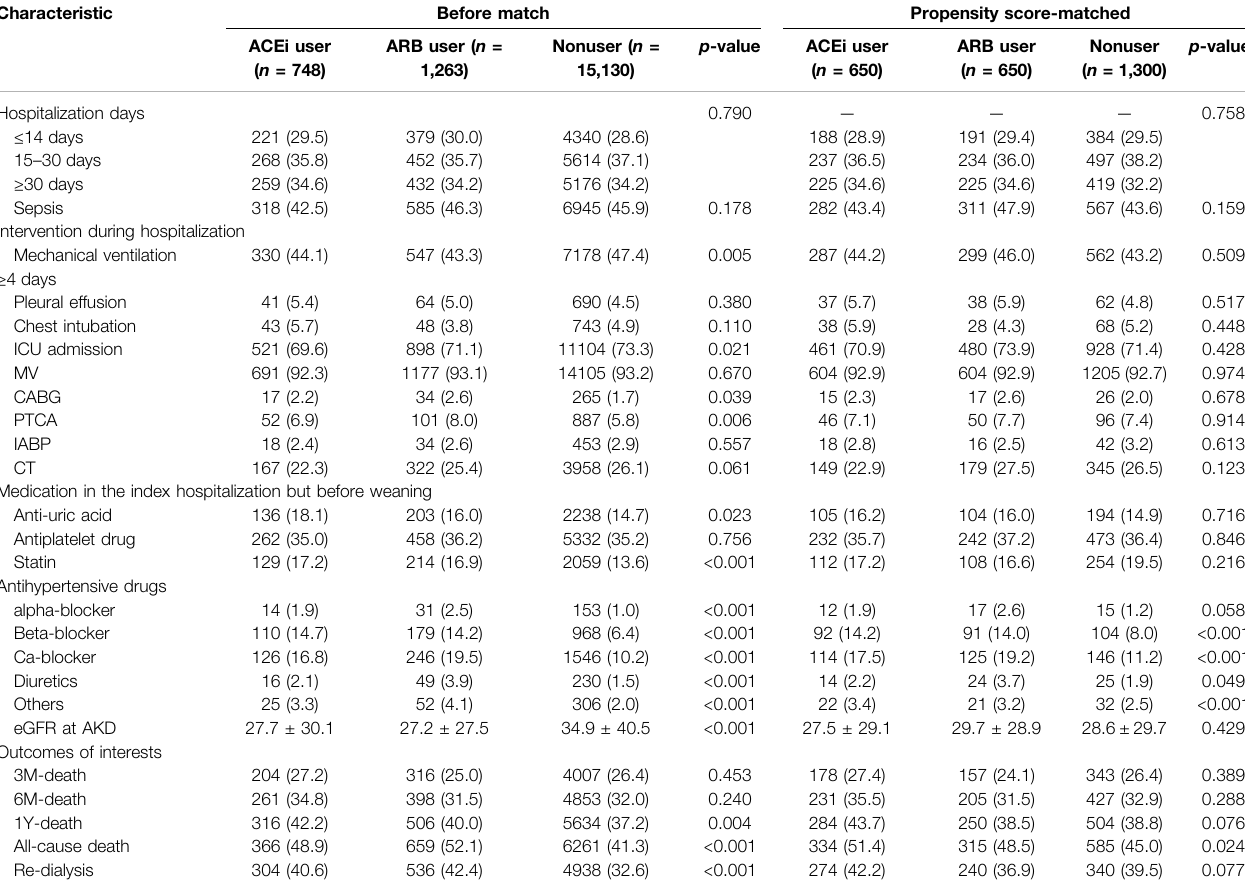
TABLE 2 | Comparison of patient characteristics at index admission and clinical outcome among ACEi users, ARB users, and other drug users. Characteristic Before